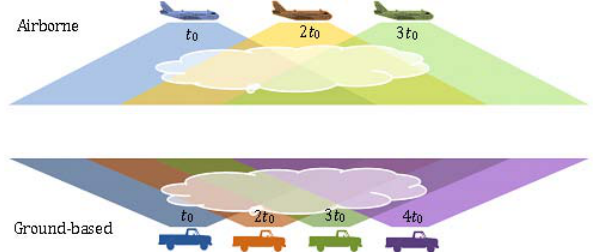
Figure 1. Illustration of the observation geometry of the ground-based and airborne tomography configurations. The cartoon shows the swaths of radiometer scan at time t = t 0 , 2 t 0 , 3 t 0 , … . Each scan cycle is indicated by different color. The positions of the platform at time t = t 0 , 2 t 0 , 3 t 0 , … are also shown in matching color.